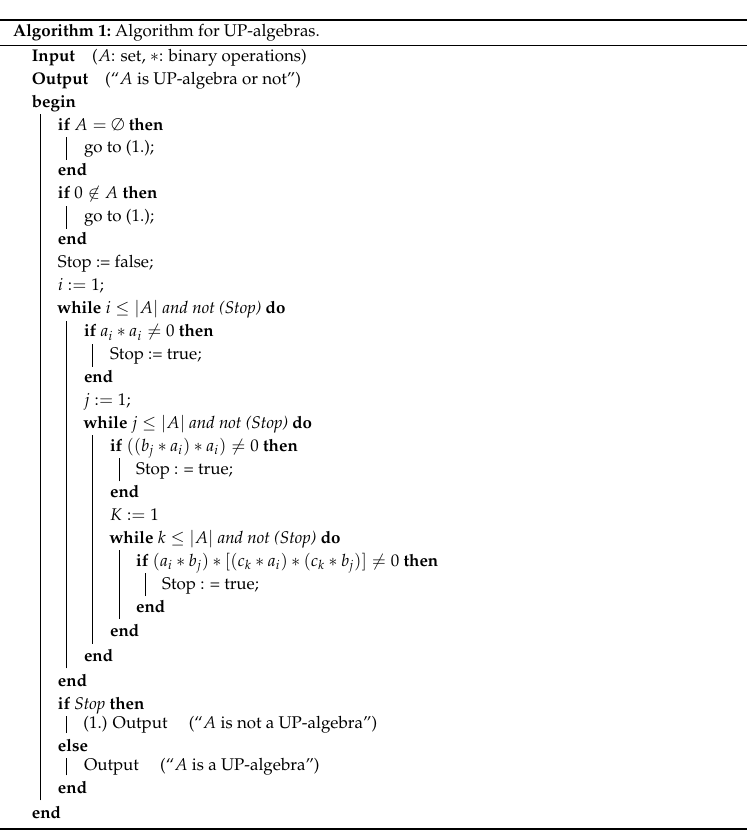
Figure 1. Graph of G ( A ) .